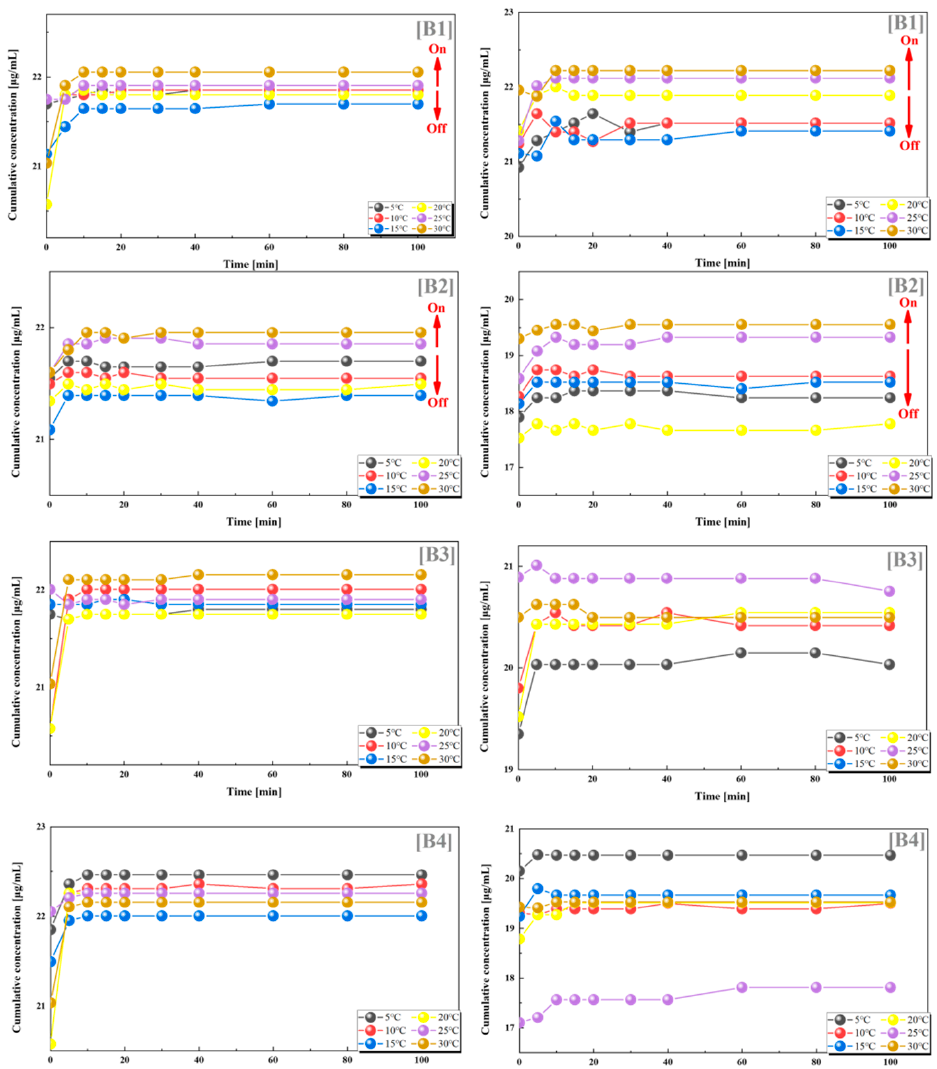
Figure 4. Release of VB12 (left) and vancomycin hydrochloride (right) from systems with different combinations of grafting rates at different temperatures. ( B1 ) 12–10%; ( B2 ) 12–15%; ( B3 ) 12–20%; ( B4 ) 12–24%. All the above combinations are for PES-g-PAAM microcapsules and PES-g-PAAC microcapsules with different grafting rates.